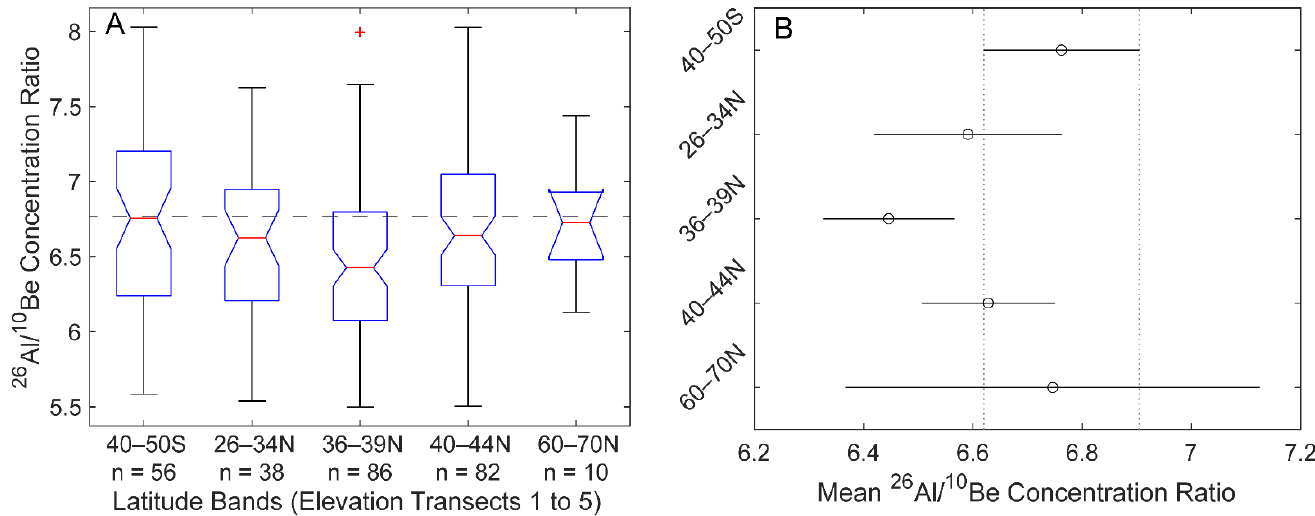
Figure 6. ANOVA boxplots ( A ) and multiple comparison of means ( B ) for elevation transects. See Figure 5 for explanation of each figure. Red cross in ( A ) is an outlier.